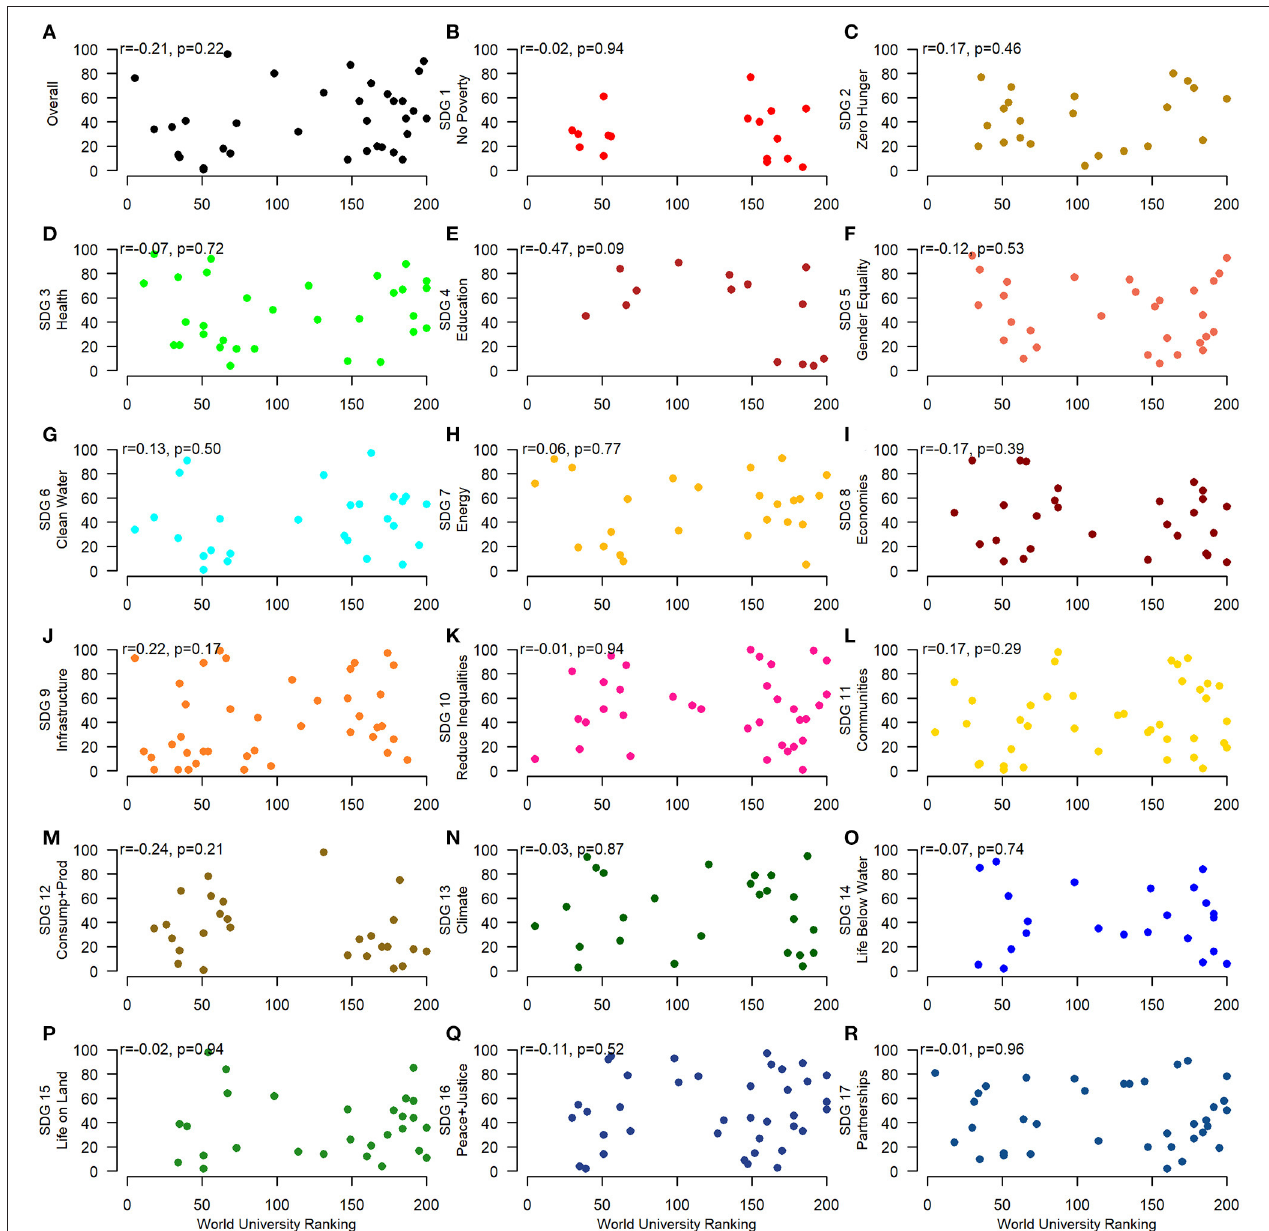
FIGURE 1 | The relationships between World University Ranks (a measure of prestige) and World Impact Ranks (contributions to the Sustainable Development Goals) in 2021. (A) the relationship between university rank and the “overall” SDG rank across all 17 SDG areas. (B–R) the relationships between world university rank and each individual SDG area, ordered by the 17 SDGs. Each point represents an individual university that has a precise ranking for both a world university ranking as well as an SDG impact ranking. The correlation strength (r), and the p-values are shown inset in each plot. Colors correspond to the colors of each specific SDG. No relationship shows significant association (all p > 0.05). Axes are scored by rank, so 1 is the best and larger numbers are